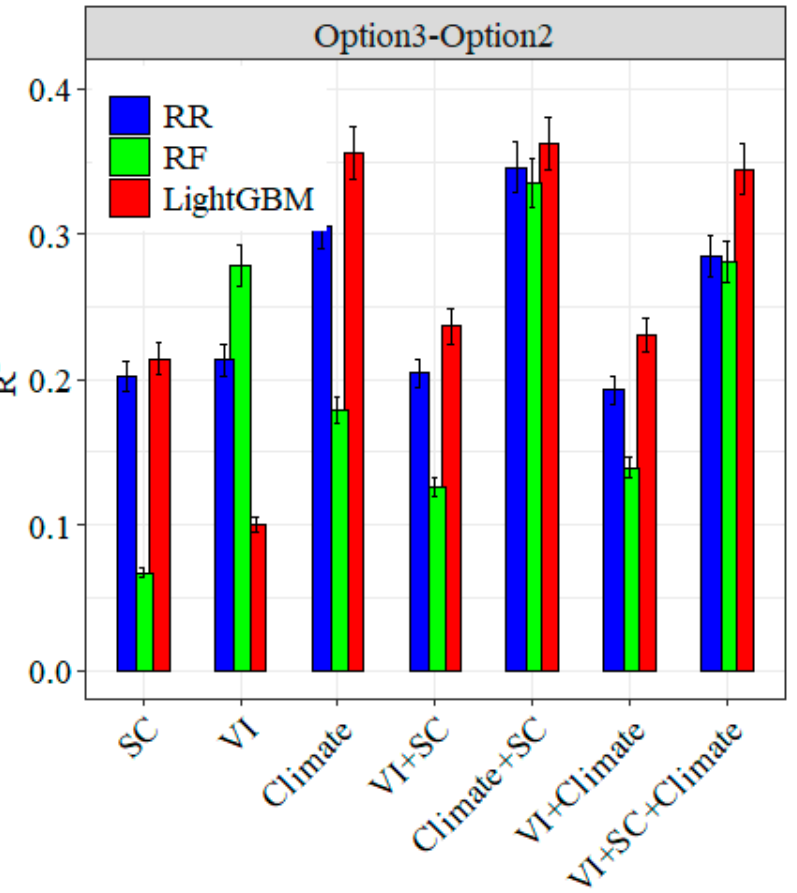
Figure A2. The delta value of prediction R2 (Option 3-Option 2)